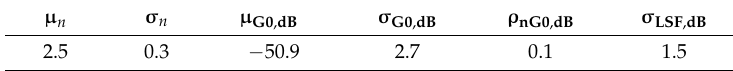
Table 3. Parameters in G db (d) for LSF